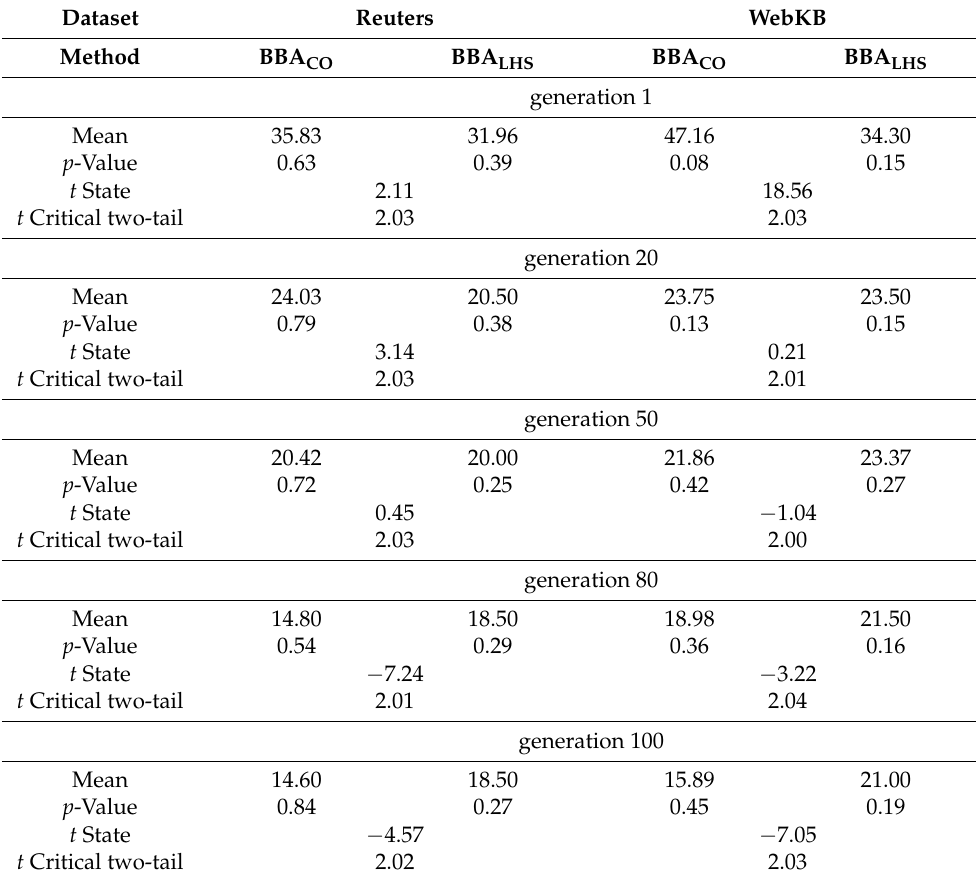
Table 5. The t -test of BRE in different generations using BBA CO and BBA LHS